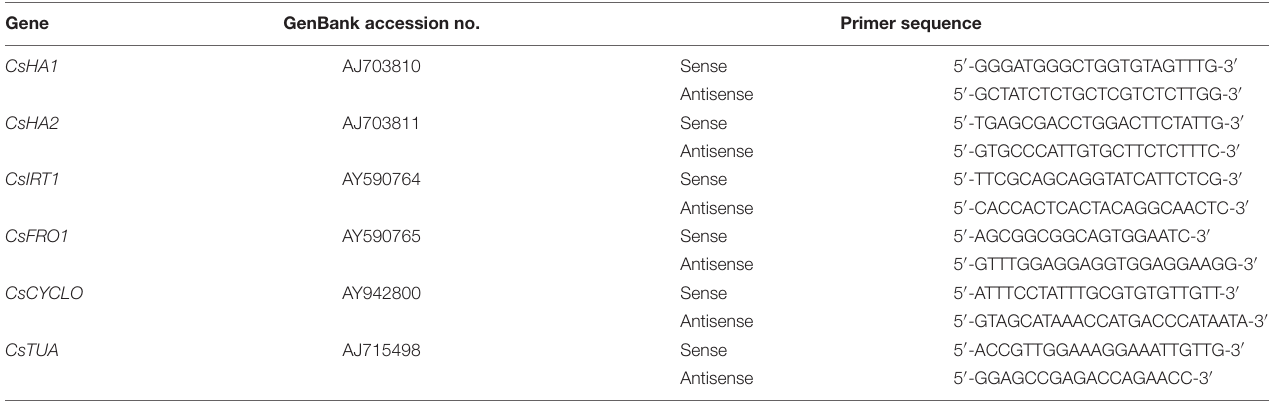
TABLE 1 | GenBank accession numbers and primer sequences used in the gene expression studies. Gene GenBank accession